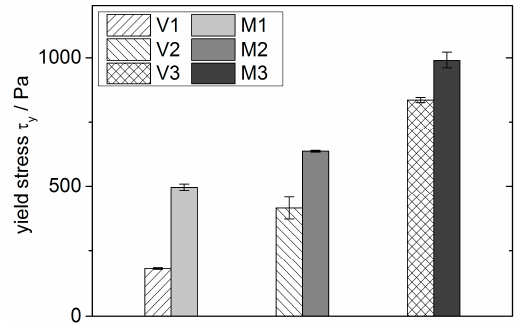
Figure 1. Yield stress values of vehicles and silver pastes determined from rotational rheometry (vane- and-cup fixture). Patterned bars represent the model vehicles (V1–V3) and filled bars the model pastes (M1–M3) containing 80 wt % silver particles.